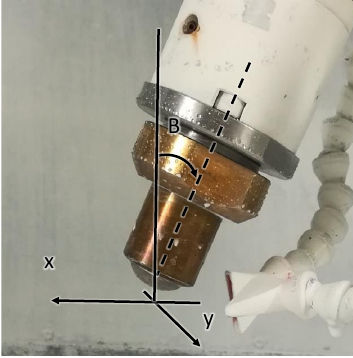
Figure 1. The Satisloh ADAPT tool as mounted in the OptoTech MCP 250